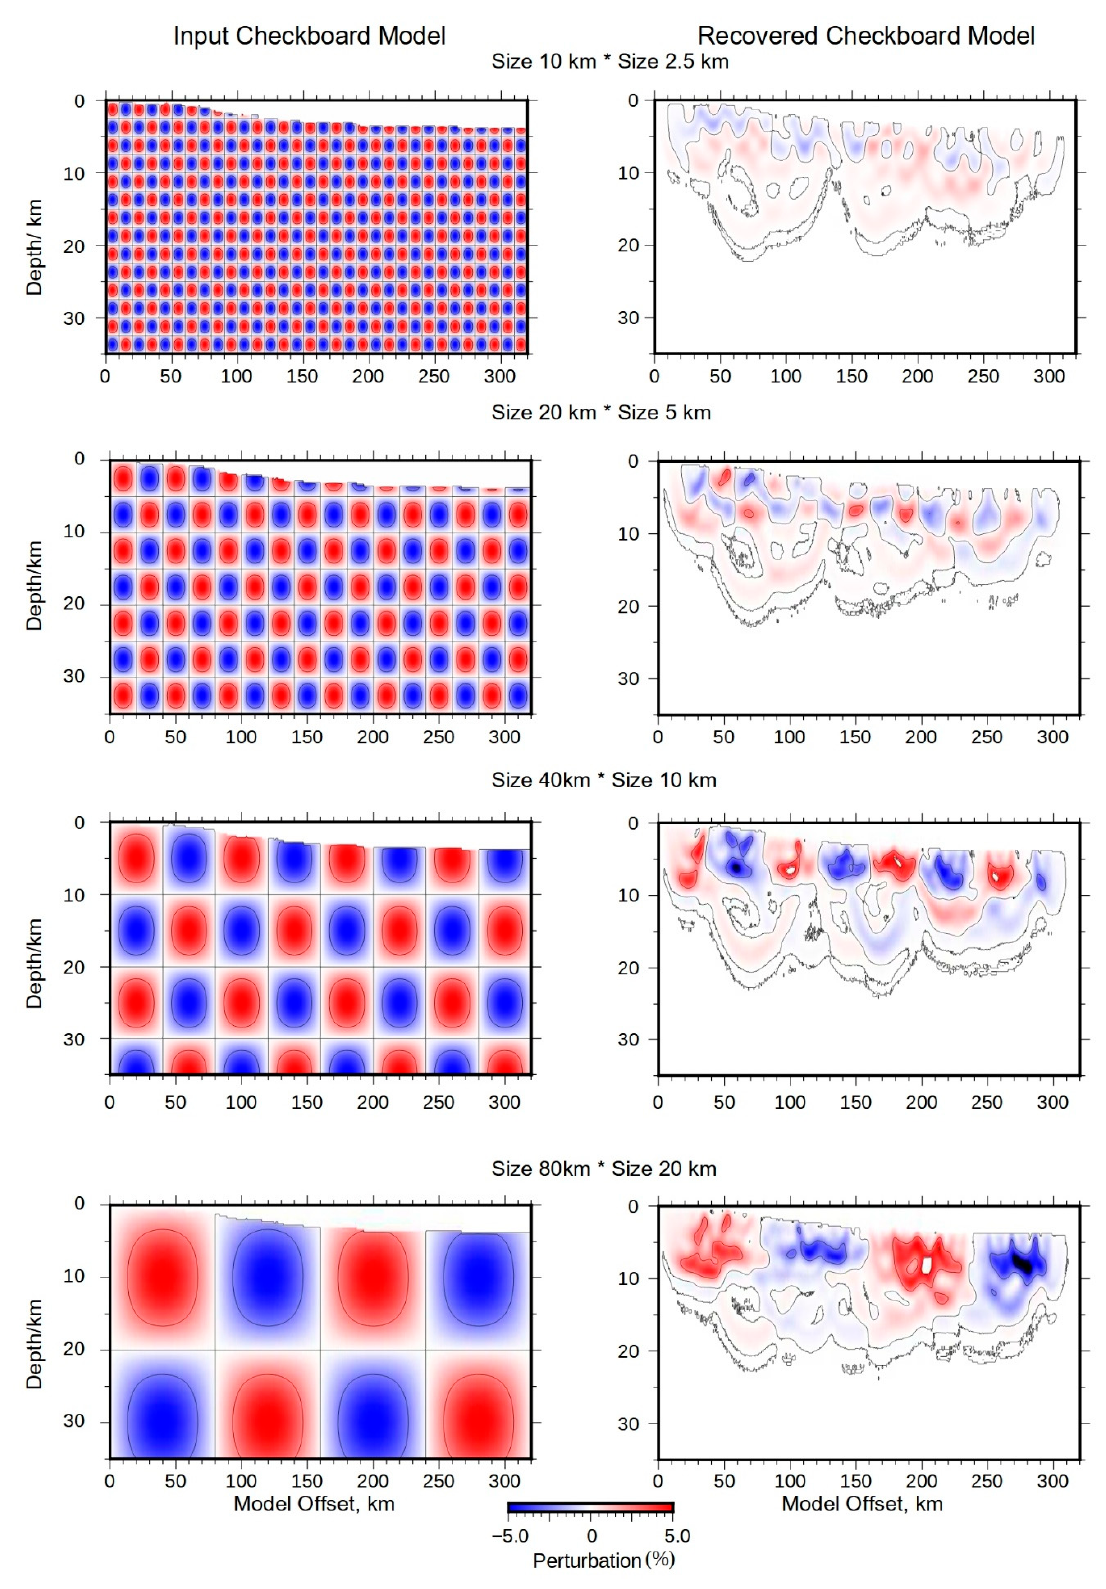
Figure 6. Four checkerboard models for velocity perturbation, using 10 × 2.5, 20 × 5, 40 × 10, and 80 × 20 km cell sizes. The left suites display starting models and the right ones show recovered models.